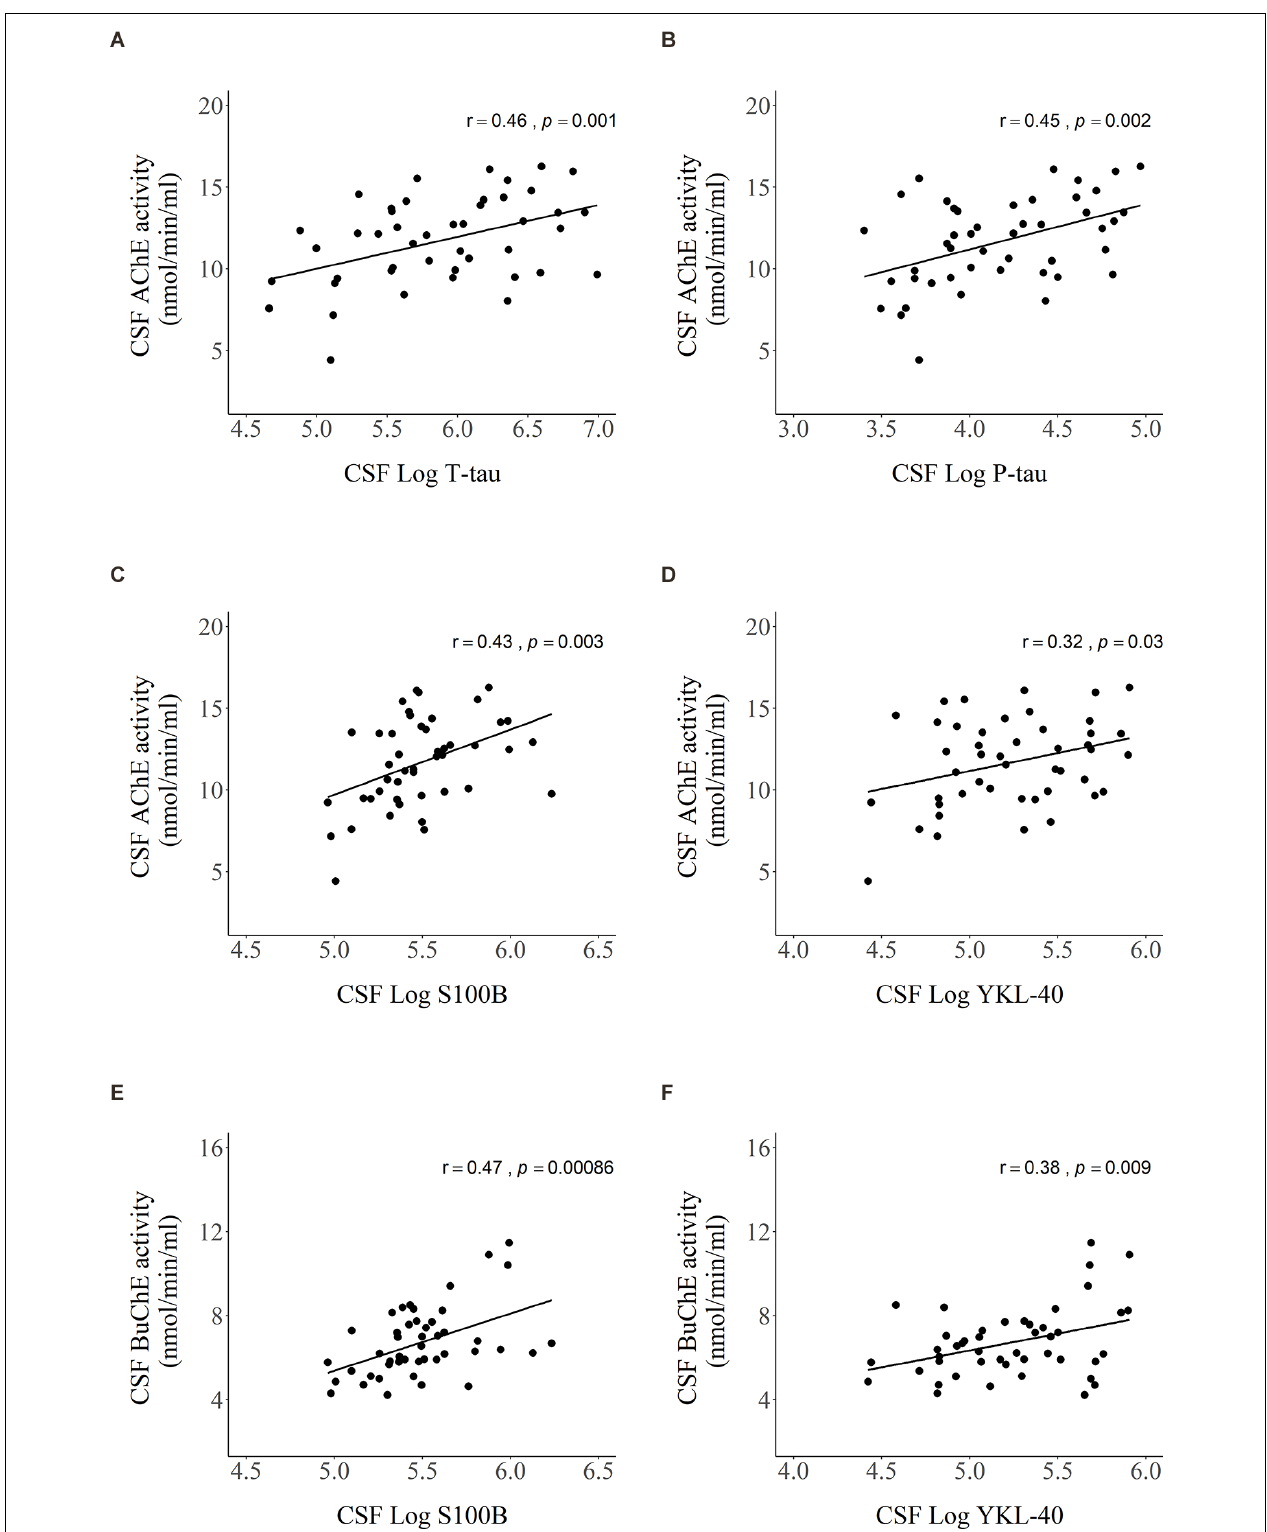
FIGURE 4 | Scatter plots presenting Pearson’s correlations between AChE activity and levels of (A) T-tau, (B) P-tau, (C) S100B, (D) YKL-40, and BuChE activity and levels of (E) S100B and (F) YKL-40 in CSF. Values of CSF proteins (T-tau, P-tau, YKL-40, and S100B) were natural log-transformed.